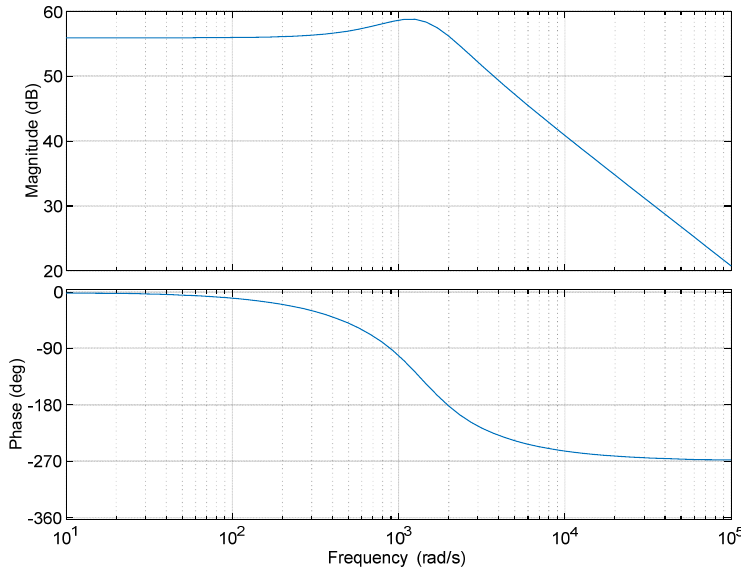
Figure 5. Gain plot ( top ) and phase plot ( bottom ) of the proposed Figure 4. Gain plot (top) and phase plot (bottom) of the proposed CSI.